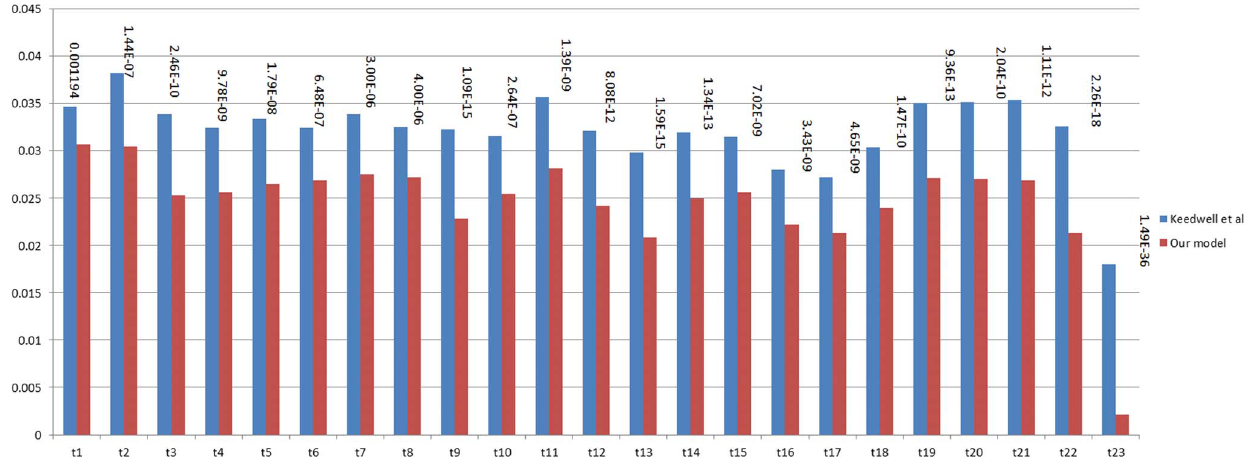
Figure 9. Comparison of fitness to yeast cell cycle microarray data. Fitness of our model is compared to that of the Keedwell et al. model on a yeast cell cycle microarray dataset. Fitness is significantly better (p , 0.05) over all